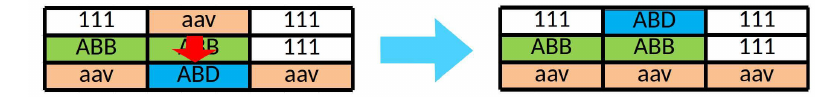
Figure 5. Second neighborhood example.